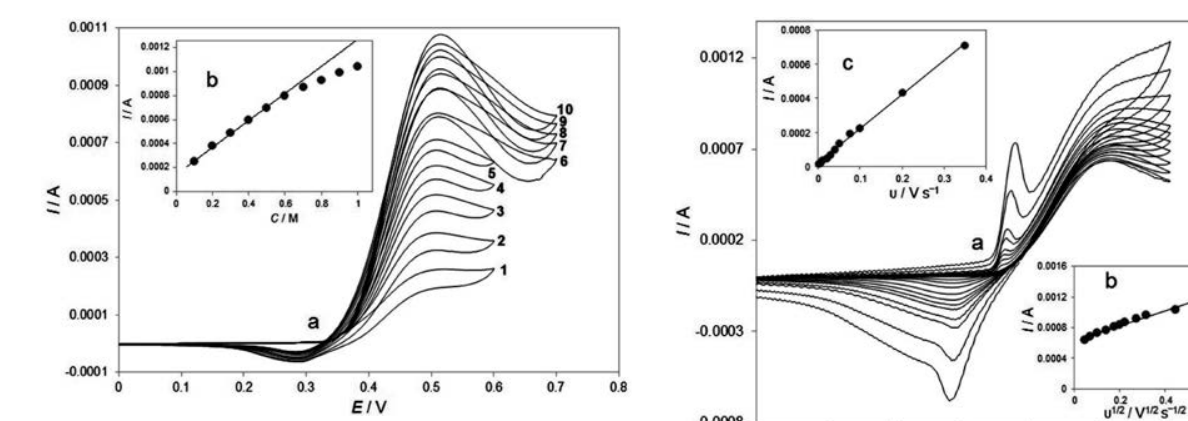
Figure 5. (a) Cyclic voltammograms of the Ni-Cu electrode in 1 M NaOH solution in the presence of (1) 0.1, (2) 0.2, (3) 0.3, (4) 0.4, (5) 0.5, (6) 0.6, (7) 0.7, (8) 0.8, (9) 0.9 and (10) 1 M of ethanol. Scan rate: 10 mV s –1 . (b) Dependency of the anodic peak current on the con- centration of ethanol.